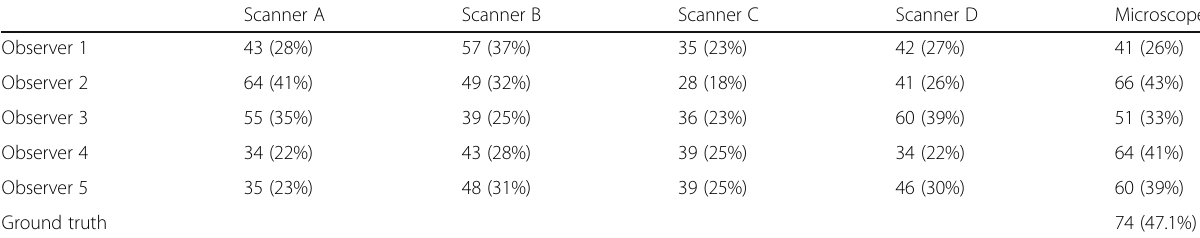
Table 1 Enumeration of candidate mitotic figures (number and percentage in total 155 candidate mitotic